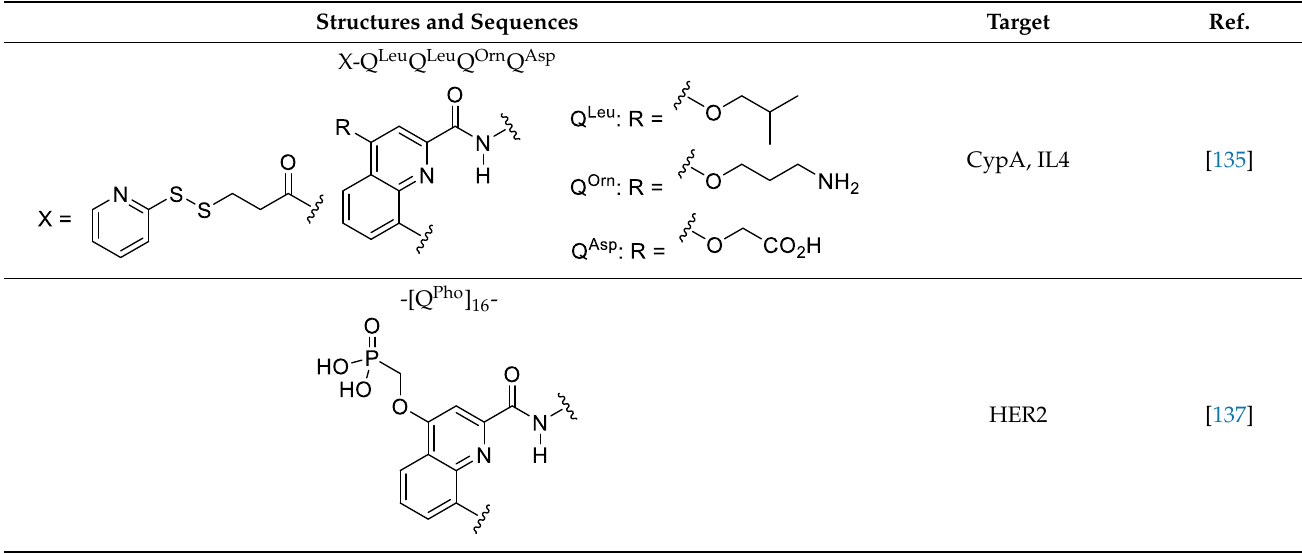
Table 6. Aromatic foldamers and their applications.